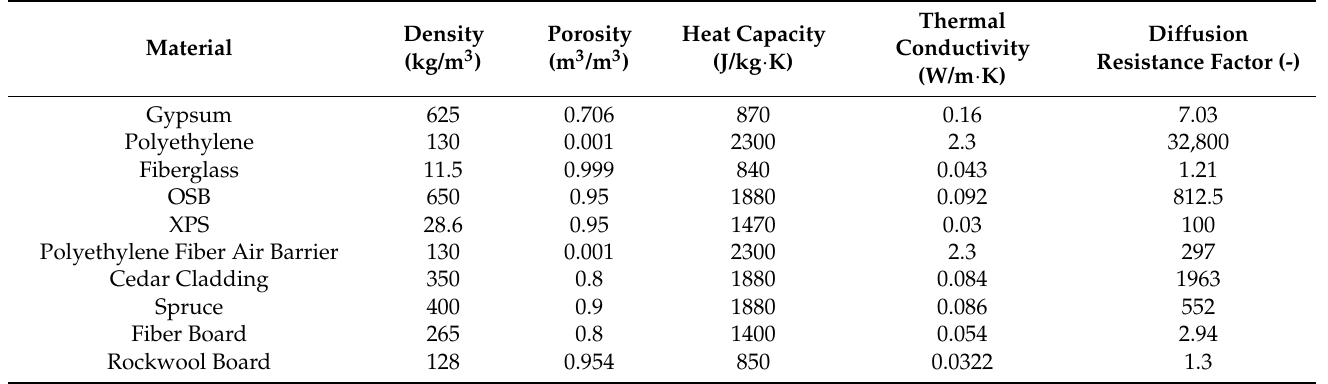
Table 3. The properties of the materials that were used for the simulations.